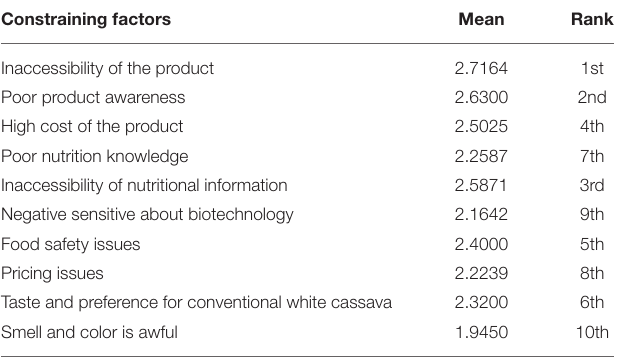
TABLE 2 | Factors mitigating against consumption of biofortified food products.